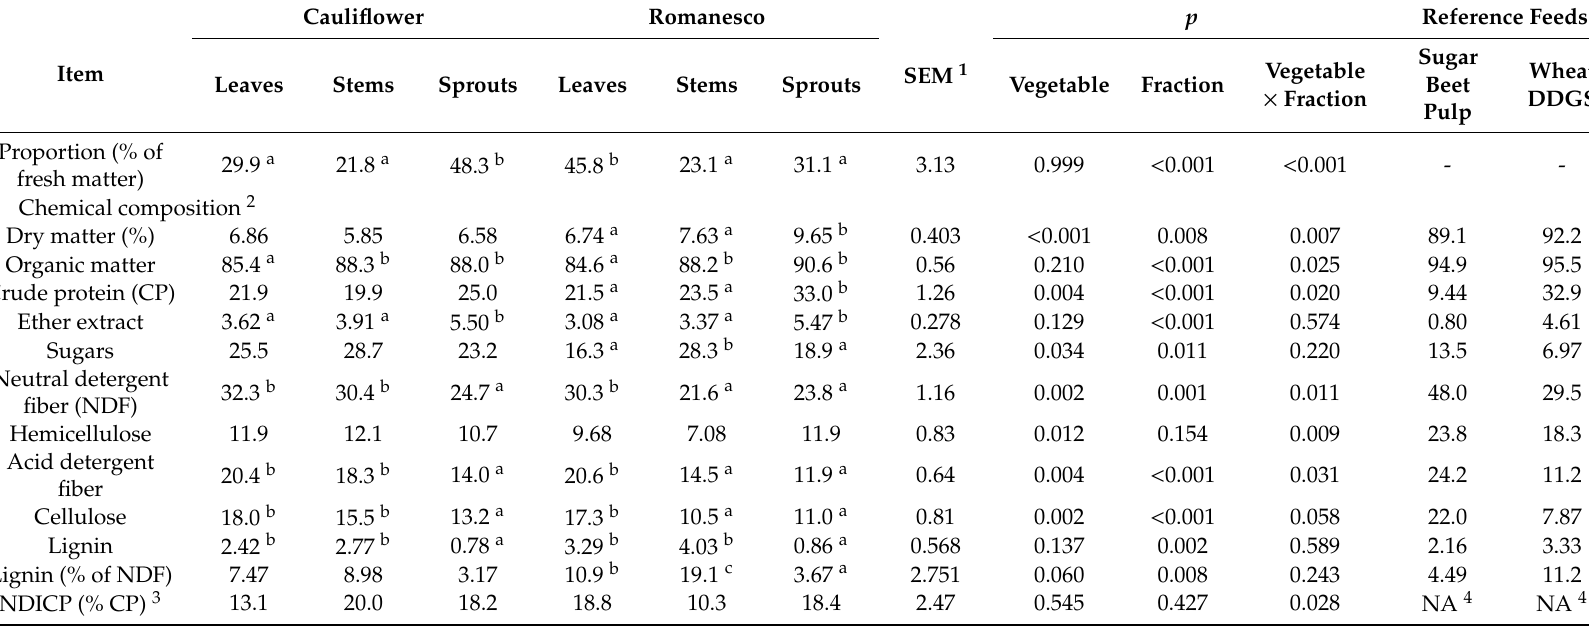
Table 1. Proportion and chemical composition of leaves, stems and sprouts of cauliflower and Romanesco samples ( n = 3) and chemical composition of sugar beet pulp and wheat DDGS samples used as reference